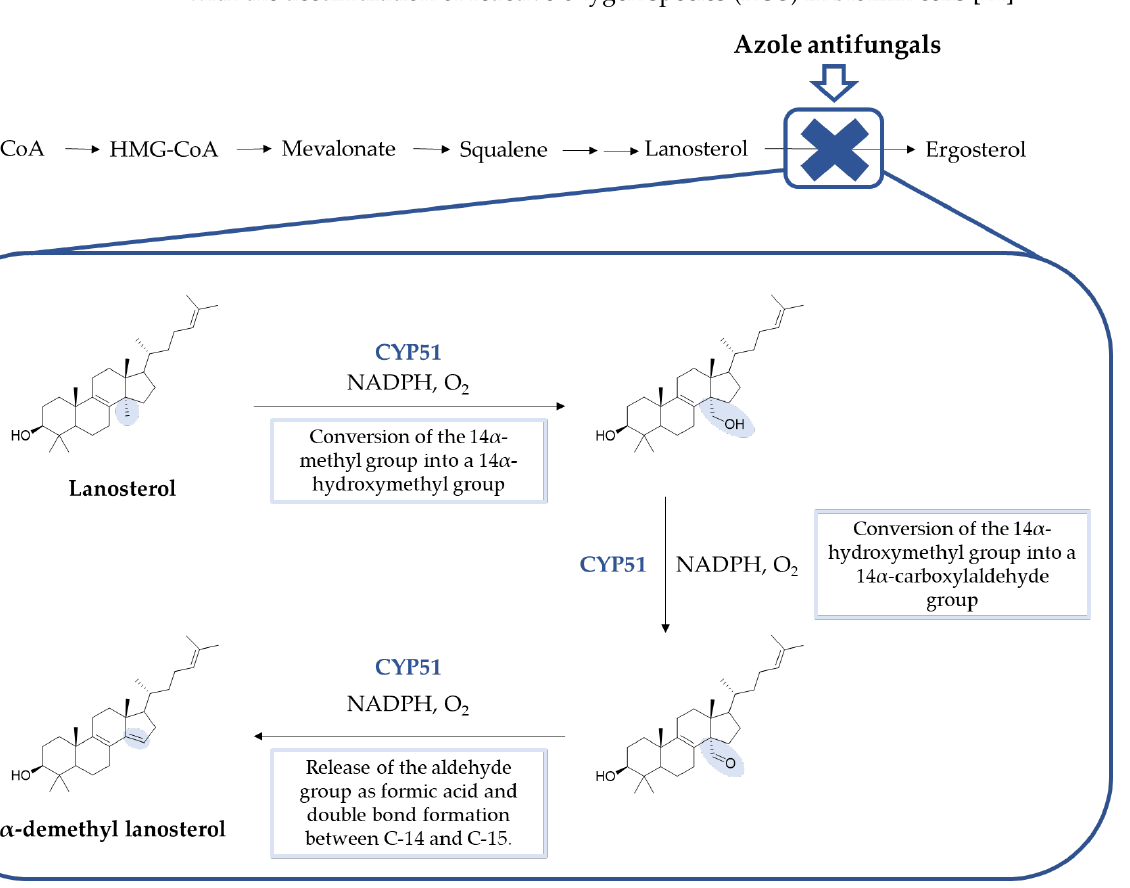
Figure 4. Summarized synthesis of ergosterol, the fungal sterol, and detailed steps of CYP51 conversion of lanosterol to 14α -demethyl lanosterol (Adapted from Peyton, 2015) [8,23] .